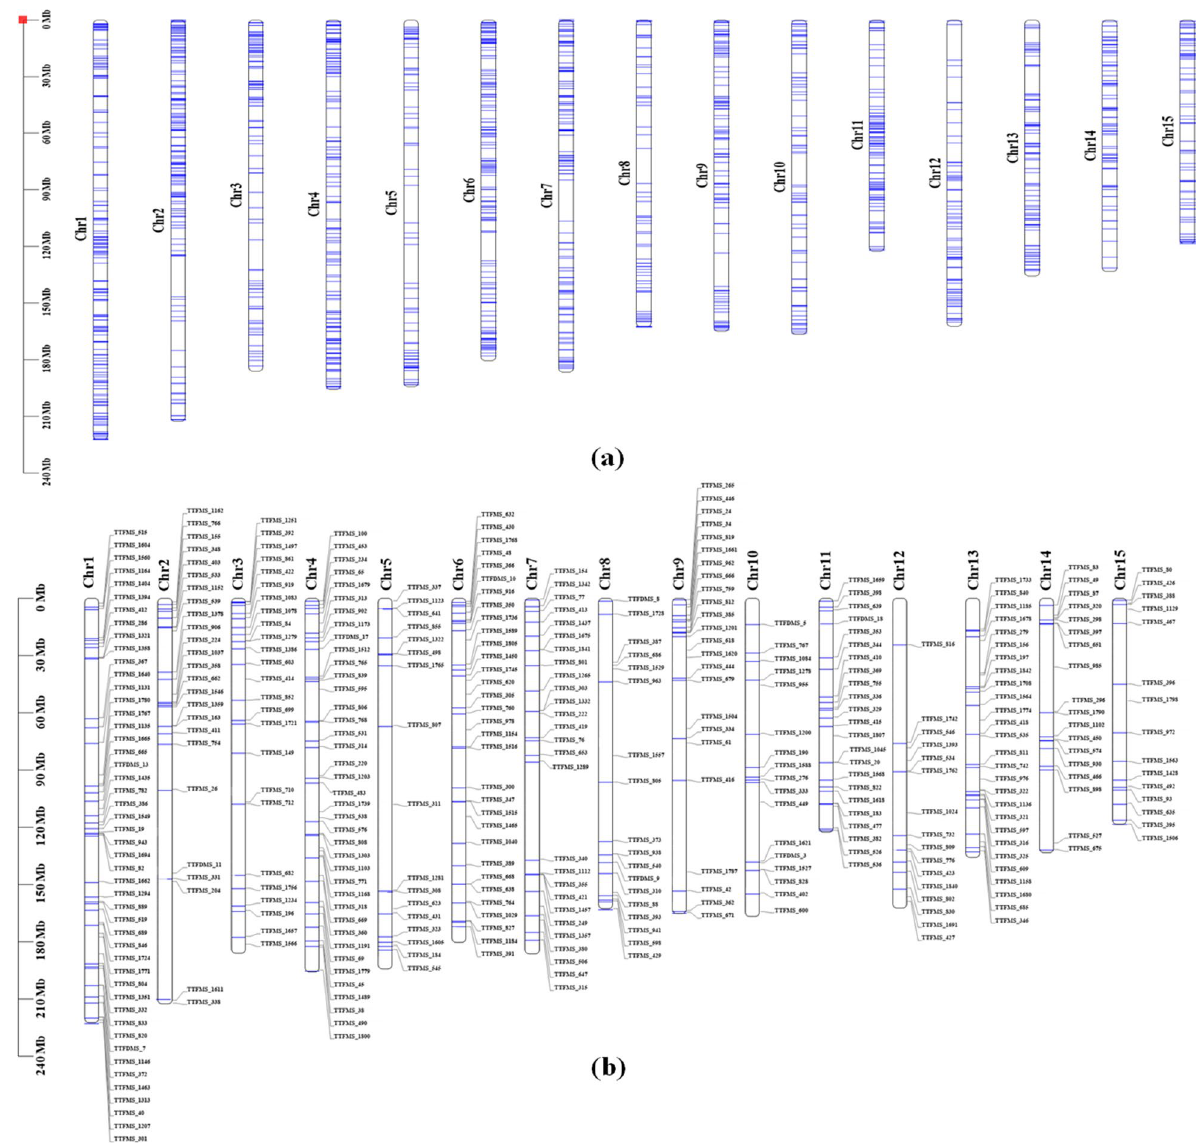
Figure 4. Chromosomal assignment of transcription factors derived SSR markers in tea CSS genome: ( a ) Overall assignment of SSR containing transcription factors to the 15 chromosomes; ( b ) Genome-wide assignment of experimentally validated polymorphic SSR markers to the 15 chromosomes of